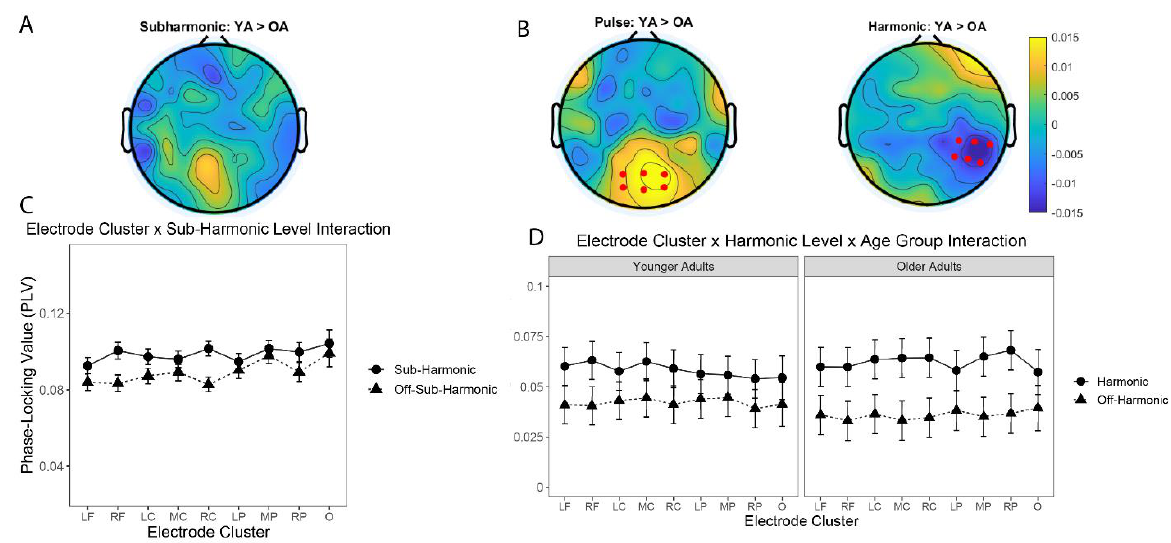
Figure 4. Neural entrainment interacts with electrode cluster and age group. ( A ) Topographies of the phase-locking values (PLVs) for the pulse and off-pulse levels. Younger adults (top row) exhib- ited higher PLVs at the pulse level in a cluster of parietal–occipital electrodes (e.g., electrode cluster O, red dots denote which channels constitute that cluster). Older adults (bottom row) exhibited a more uniform topography of PLVs at the pulse level. ( B ) Mean PLVs representing a three-way in- teraction between rhythm level (pulse, off-pulse), electrode cluster (nine clusters), and age group (younger adults, older adults). Error bars are standard error of the mean (SE).